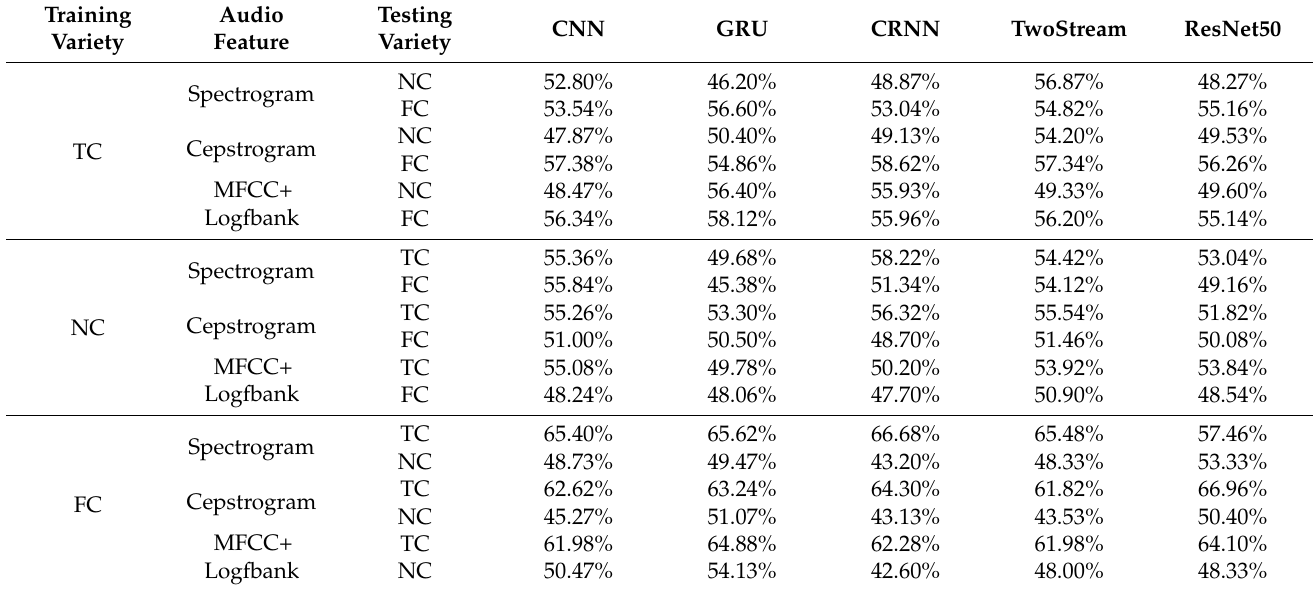
Table 3. Testing results of using calls of chicks of different varieties for training and